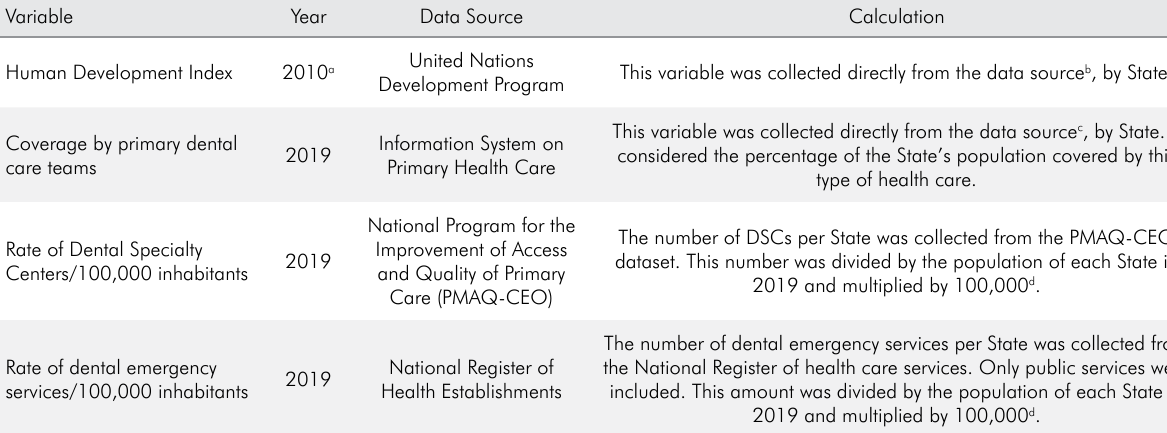
Table 1. Exposure variables: year, data sources, and calculation